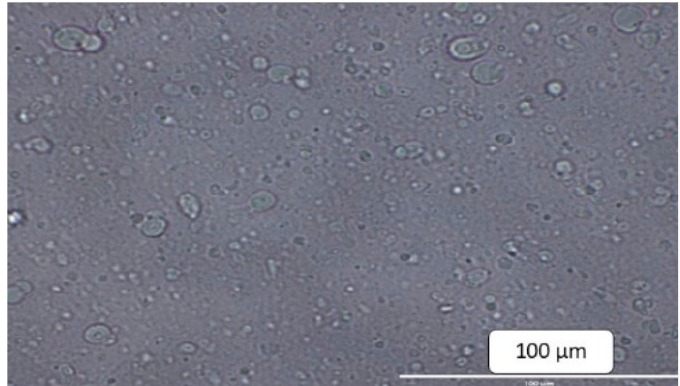
Figure 2. Microscopic image of proliposomes (F8) after hydrating with purified water. Table 7. Particle size, zeta potential, and encapsulation efficiency for proliposomal formulations ( n =